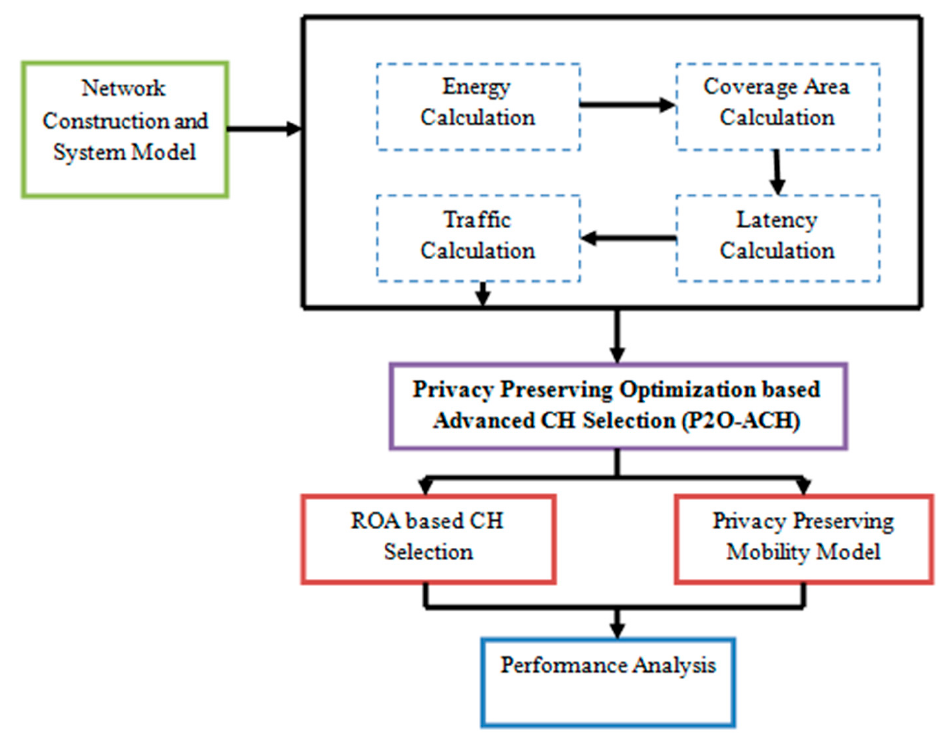
Figure 1. Architecture of the Proposed P2O-ACH Method.